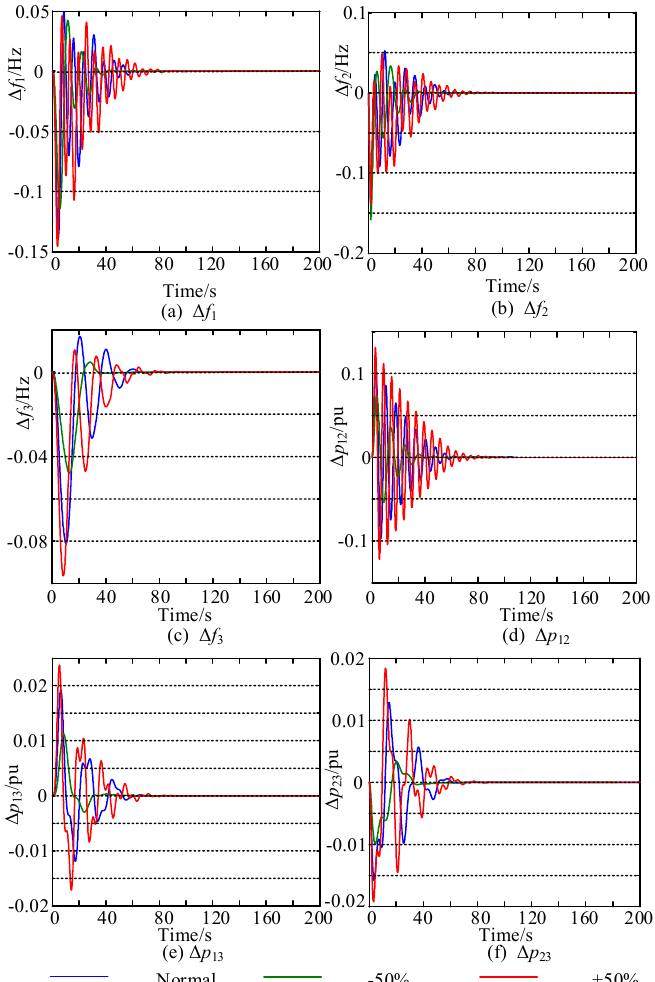
Figure 5. Results contrast curve under the change of system parameters: ( a ) frequency deviation of the first CA; ( b ) frequency deviation of the second CA; ( c ) frequency deviation of the third CA; ( d ) tie-line power deviation between the first and second CAs; ( e ) tie-line power deviation between the first and third CAs; ( f ) tie-line power deviation between the second and third CAs.